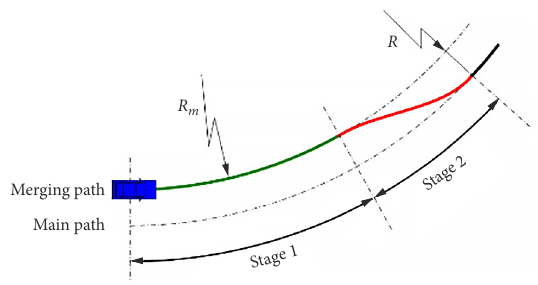
Figure 6. Division of vehicle